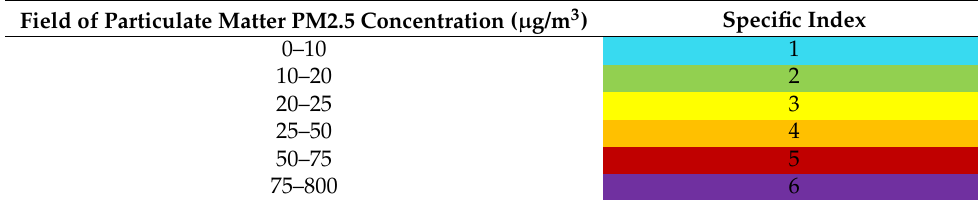
Table 1. Specific index for the concentration of